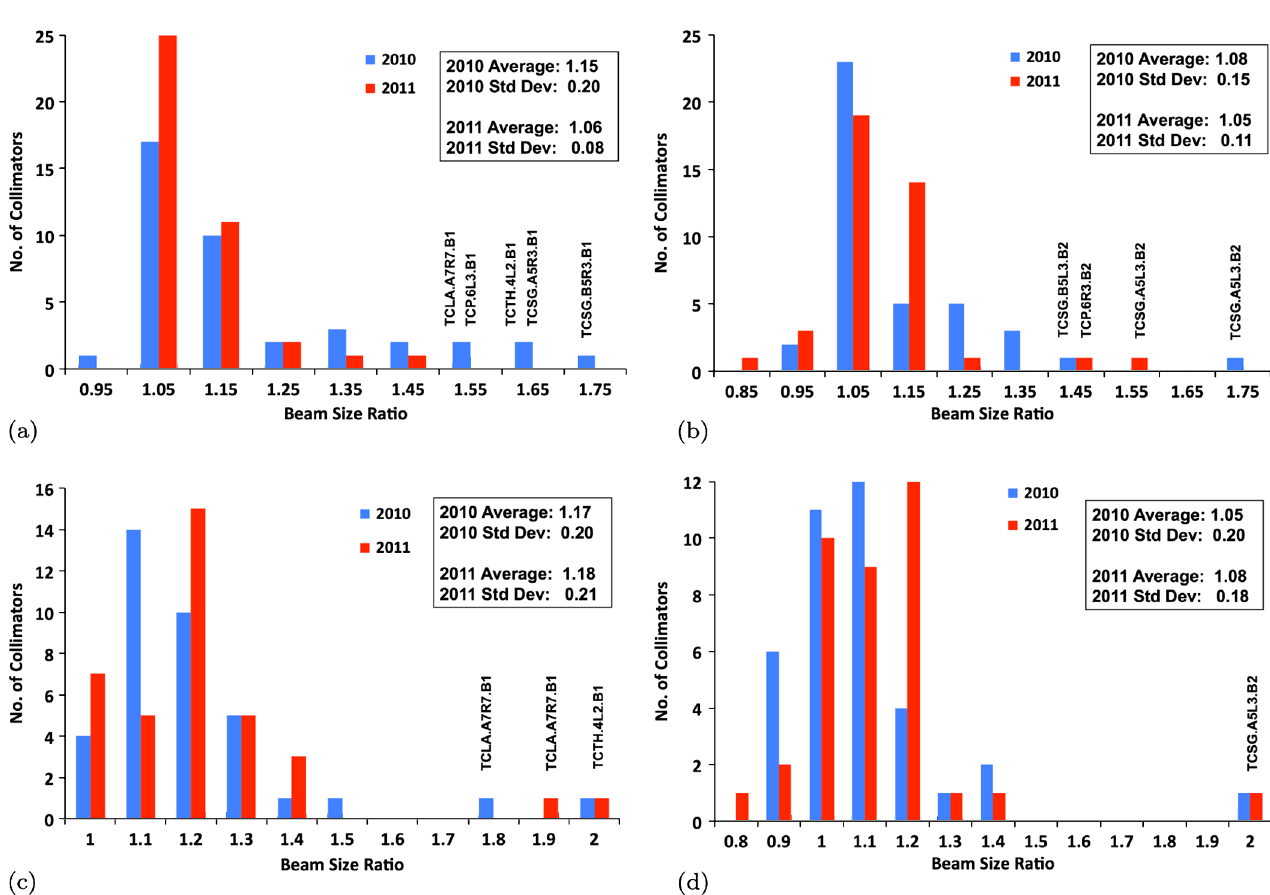
FIG. 9. Change in the beam size ratios between 2010 and 2011 for the B1 (left) and B2 (right) collimators. Collimators with a large beam size ratio are labeled: (a) 450 GeV B1 beam size ratios; (b) 450 GeV B2 beam size ratios; (c) 3.5 TeV B1 beam size ratios; (d) 3.5 TeV B2 beam size ratios. The values are correct for the 3 collimators with the largest beam size ratio at 3.5 TeV (TCLA.A7R7.B1, TCTH.4L2.B1, and TCSG.A5L3.B2) before the tunnel